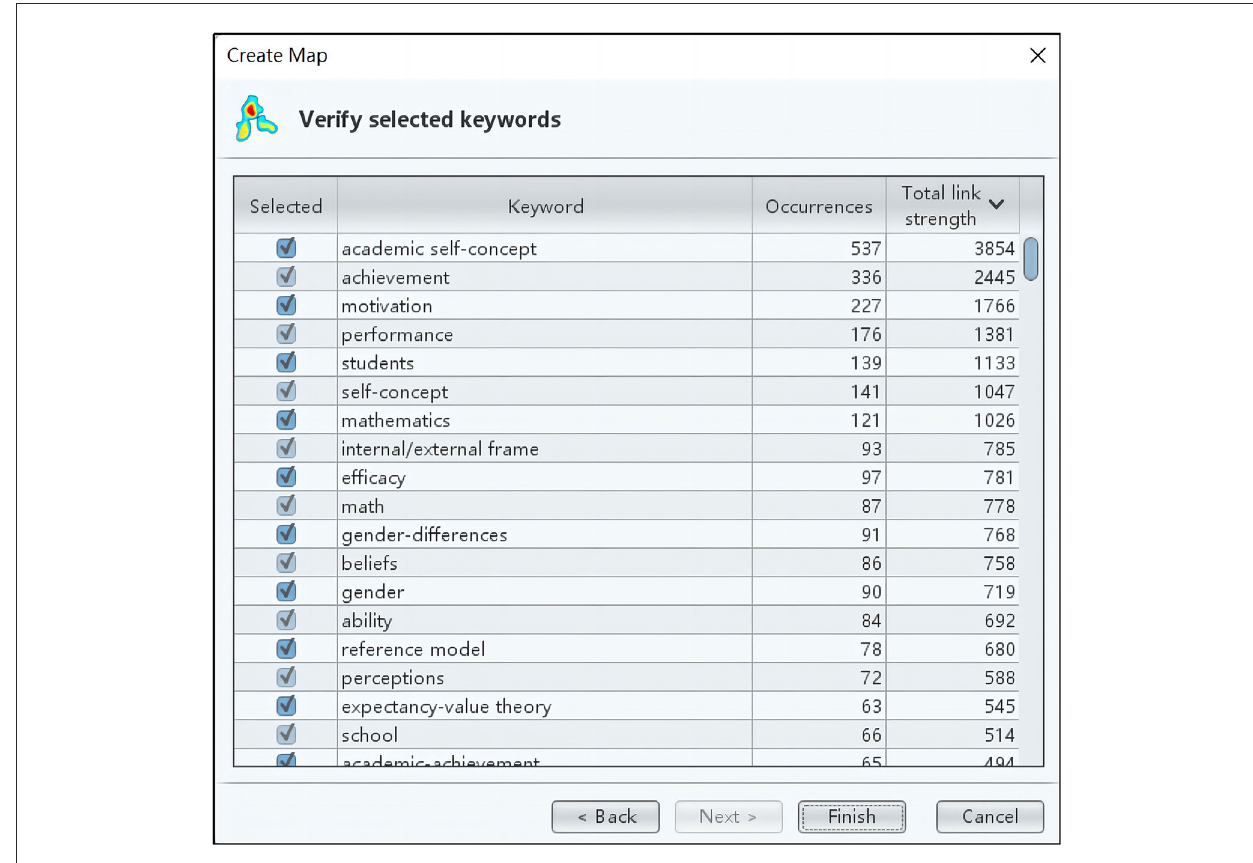
FIGURE3 Total link